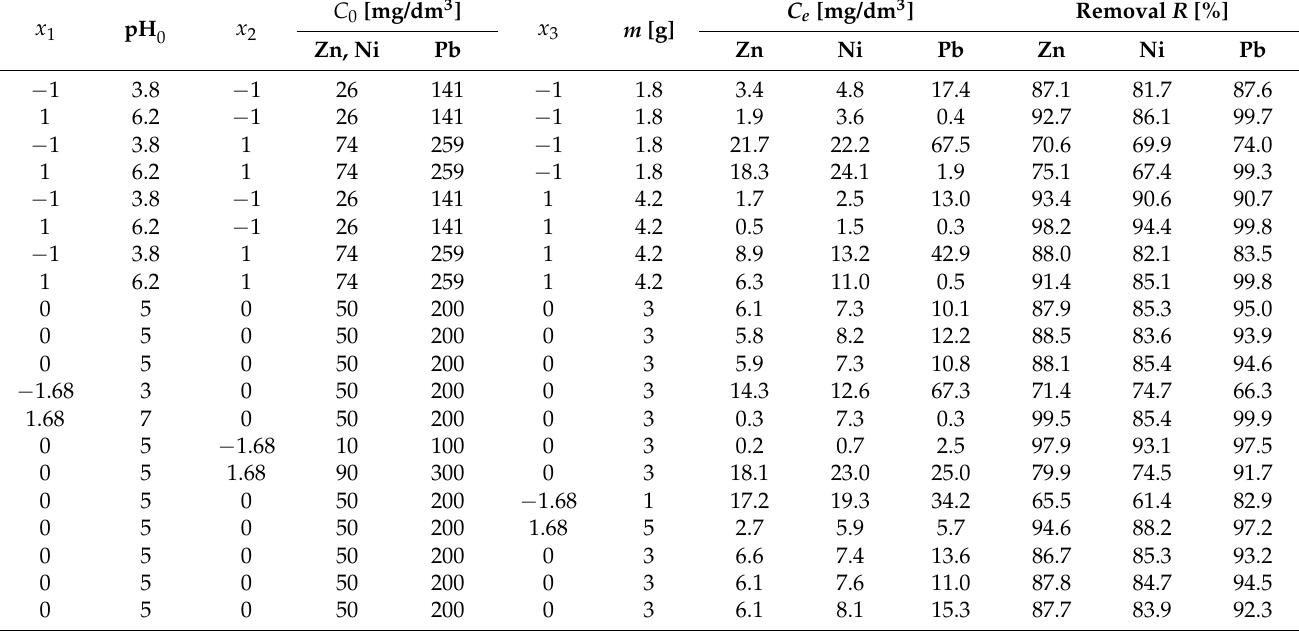
Table 4. CCD3 input and response